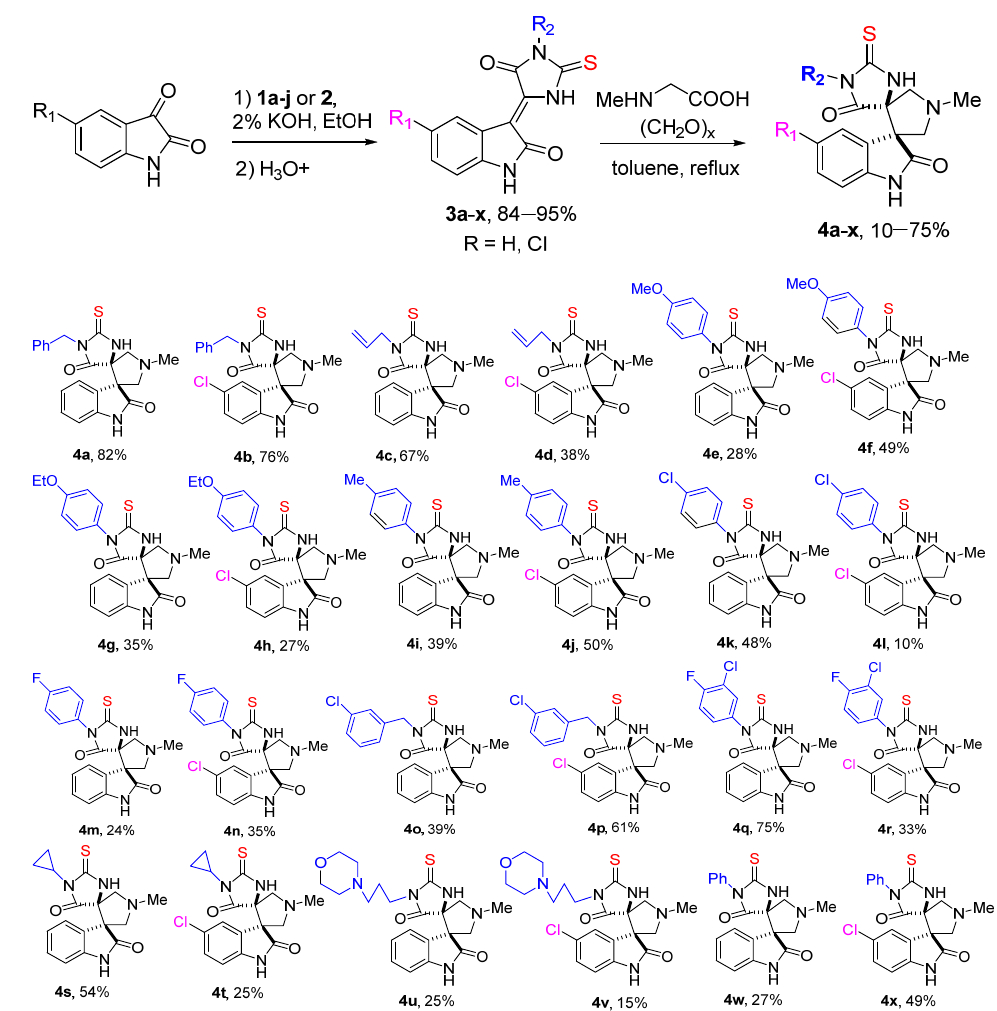
Scheme 2 . Synthesis of 3-(5-oxo-2-thioxoimidazolidin-4-ylidene)indolin-2-ones 3a — x and Scheme 2. Synthesis of 3-(5-oxo-2-thioxoimidazolidin-4-ylidene)indolin-2-ones 3a – x and dispiroin- dispiroindolinines 4a — x .